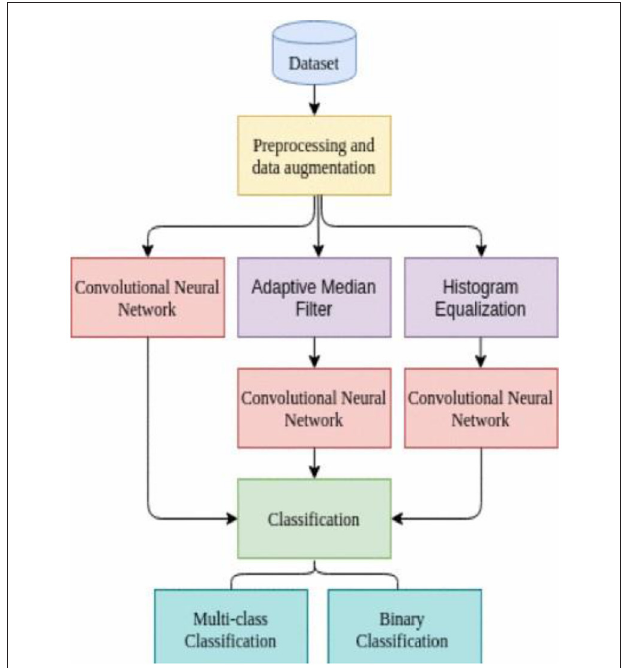
FIGURE 5 | Multi-layered convolutional neural network-based flow diagram of CoviNet (Knipe, 2020).